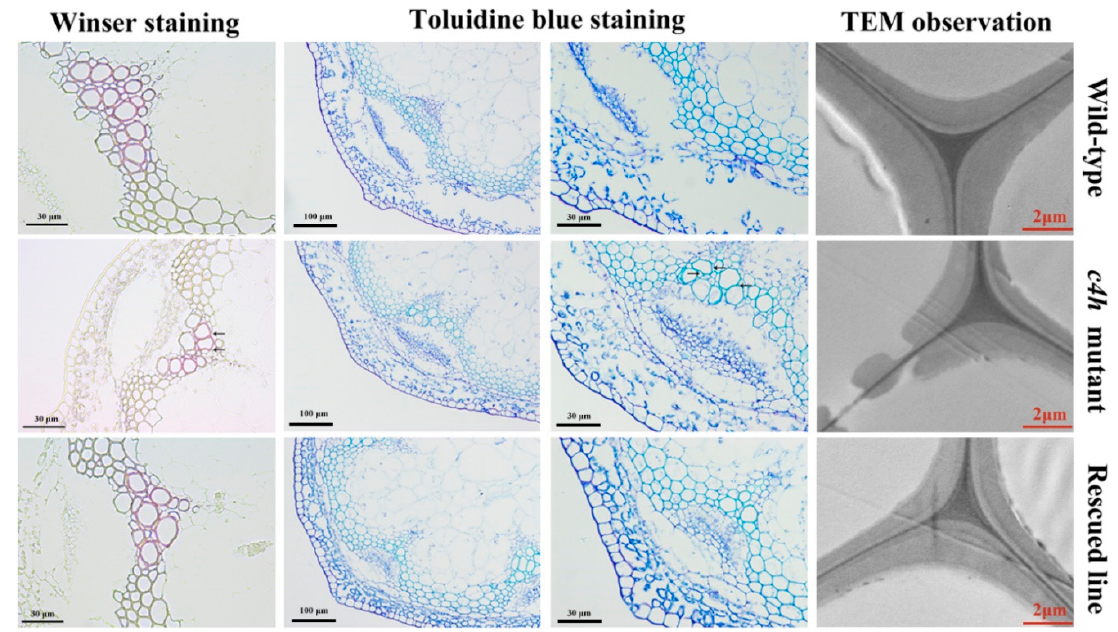
Figure 10. Histochemical staining and ultramicroscopic observation of cell walls in the inflorescence stems of c4h mutants, WT, and rescued lines. Some cell wall irregularities or collapses are indicated by the arrows. Three plants of each genotype were selected for observation.